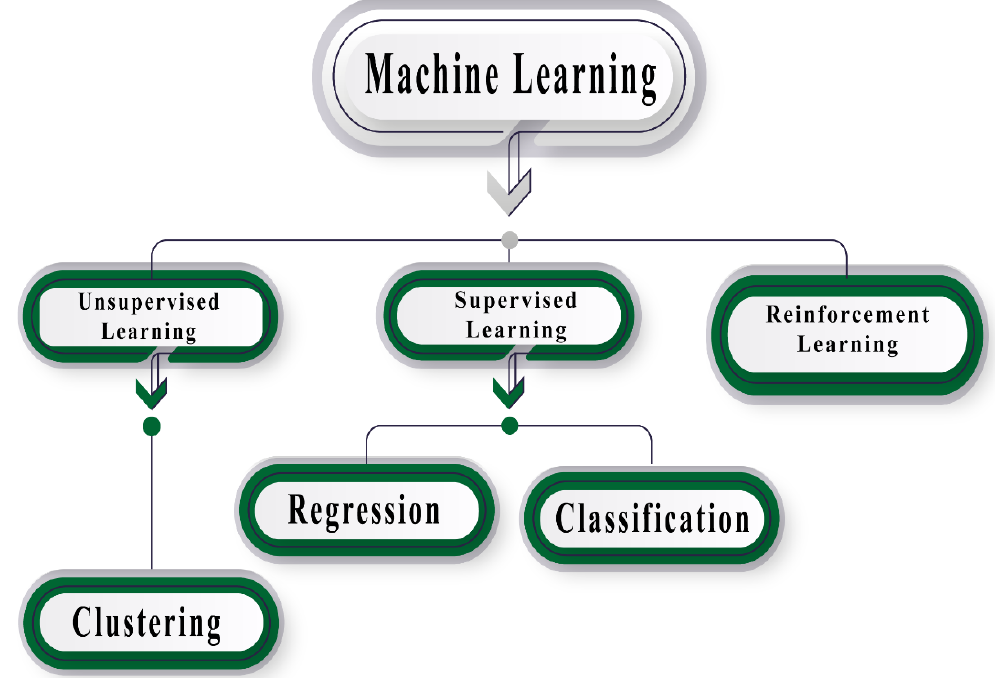
Figure 2. ML categories according to the nature of the features space.